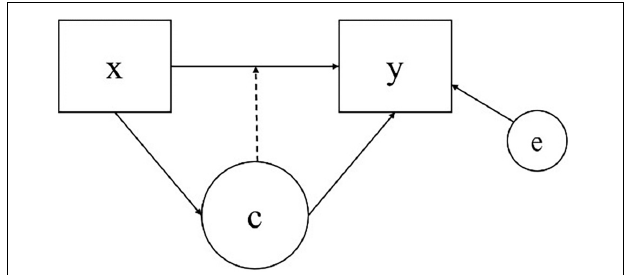
FIGURE 1 | Diagram of an regression mixture modeling